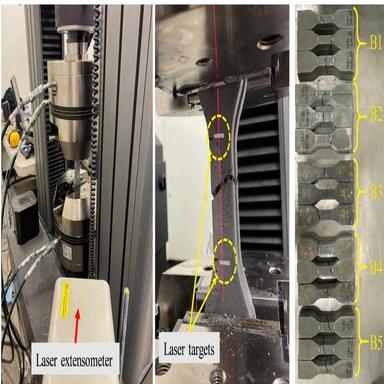
Direct tension testing of NP-UHPC dog-bone specimens.